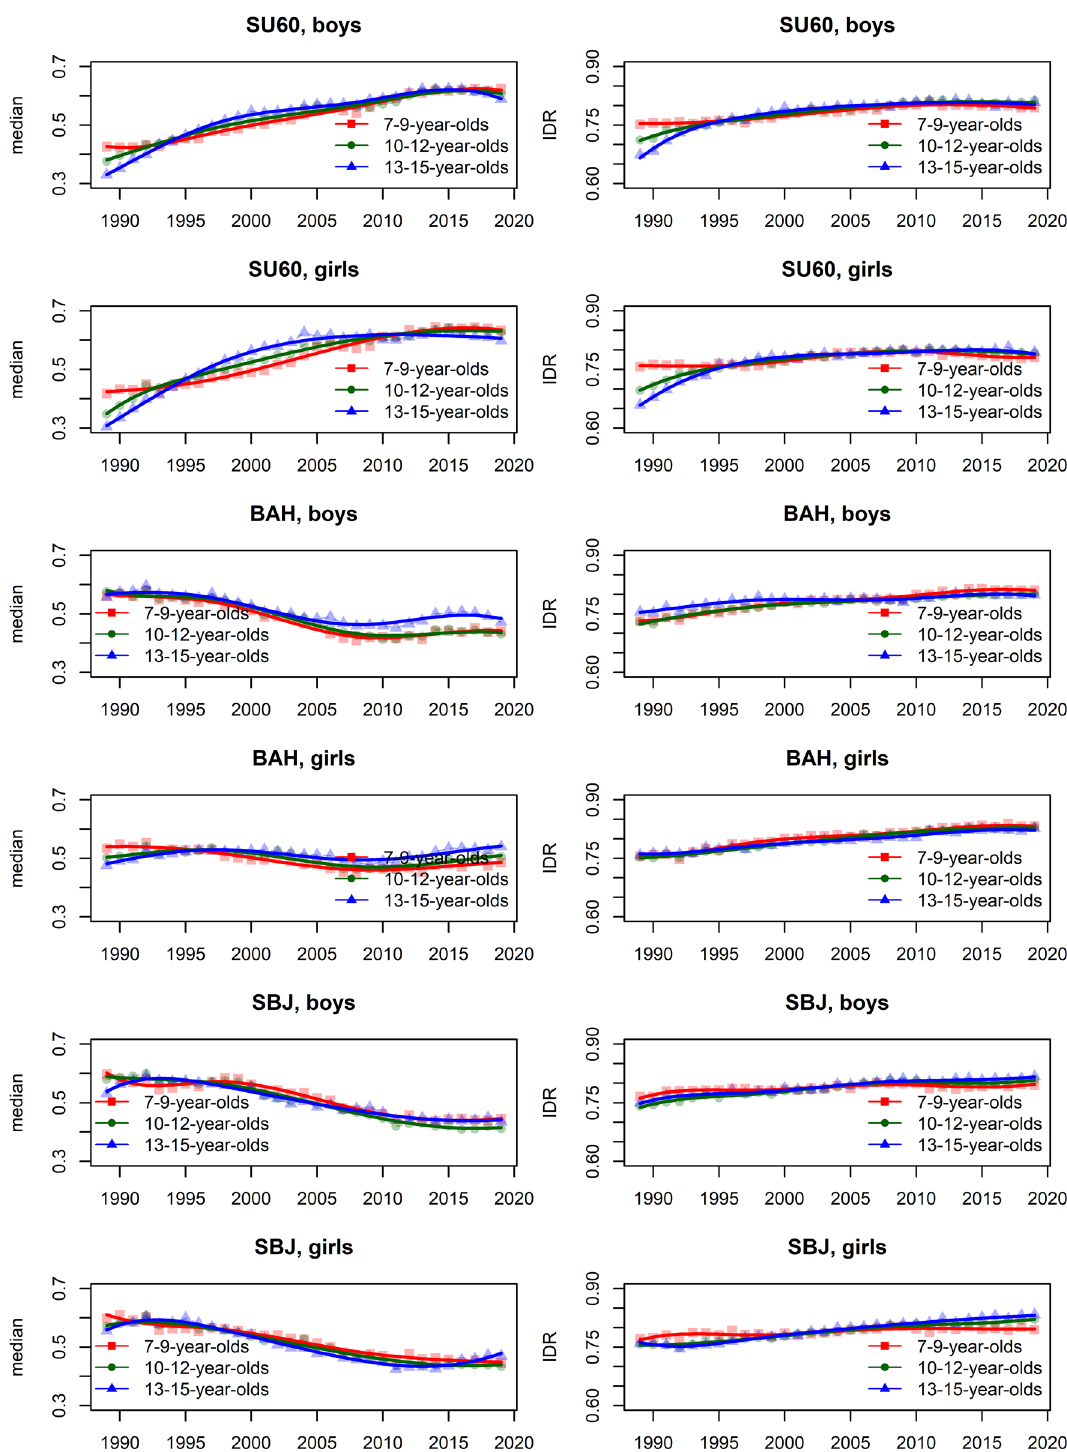
Figure 3. Time trends (medians and IDR) in the SU60, BAH, and SBJ between 1989 and 2019 by gender, across three age groups: 7–9 years, 10–12 years, and 13–15 years. Points and solid lines are the estimated values and smoothed estimated values, respectively, adjusted by region (the results are shown fixing the region to its mode). In the plots showing the estimated medians, the estimates above (below) 1/2 imply that the results were better (worse) than in the period 1989–2019 when comparing children of the same gender and age. See Supplementary Information for more results including the uncertainty in the point